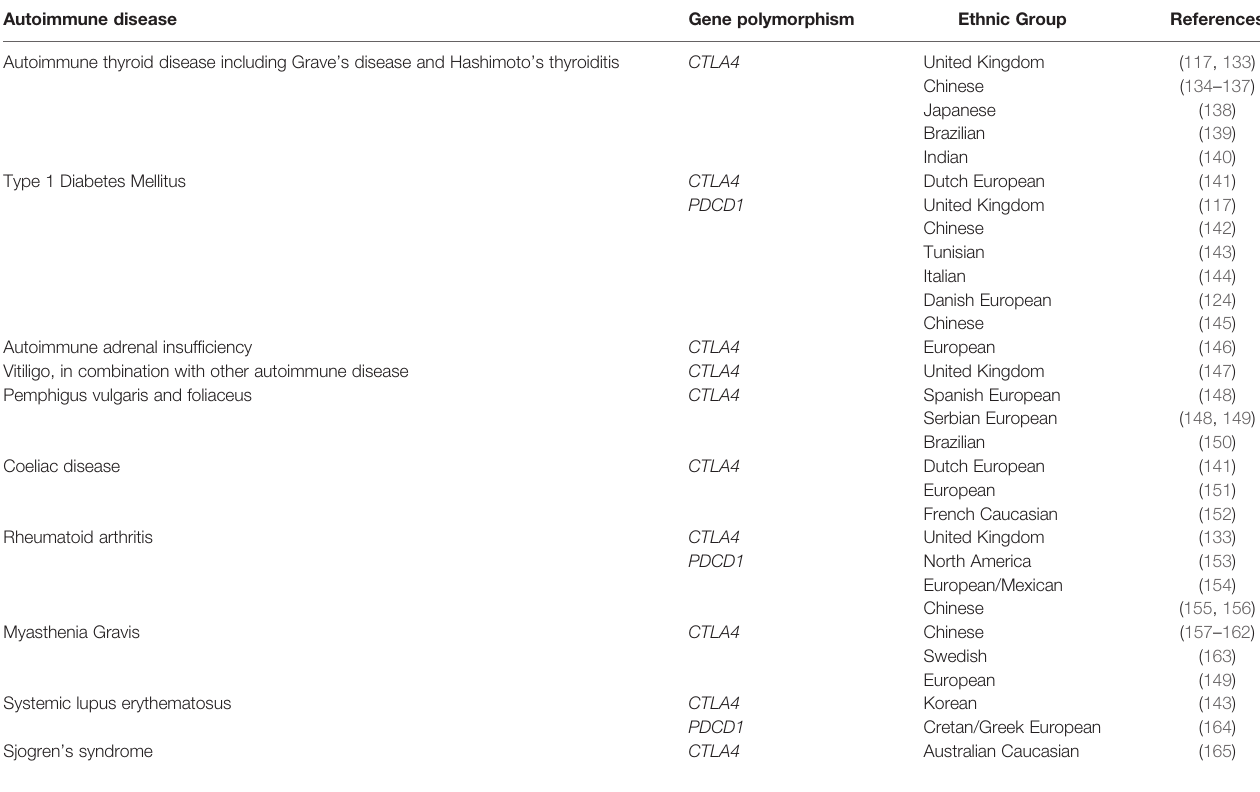
TABLE 2 | Germline CTLA4 and PDCD1 gene polymorphisms are associated with autoimmune diseases. Autoimmune